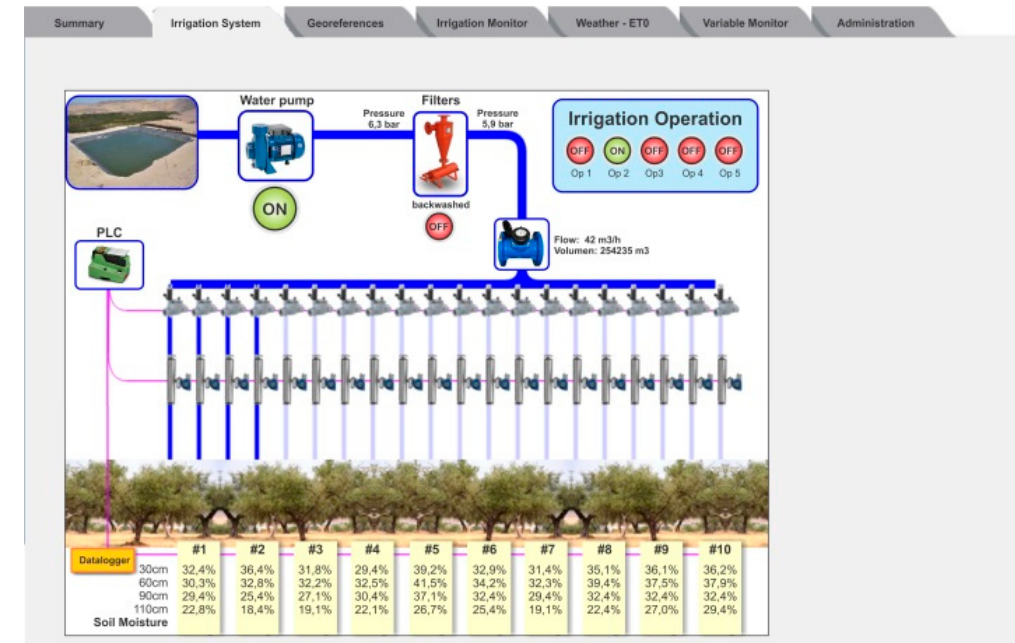
Figure 4. The Irrigation System tab shows information related to the irrigation system operation.